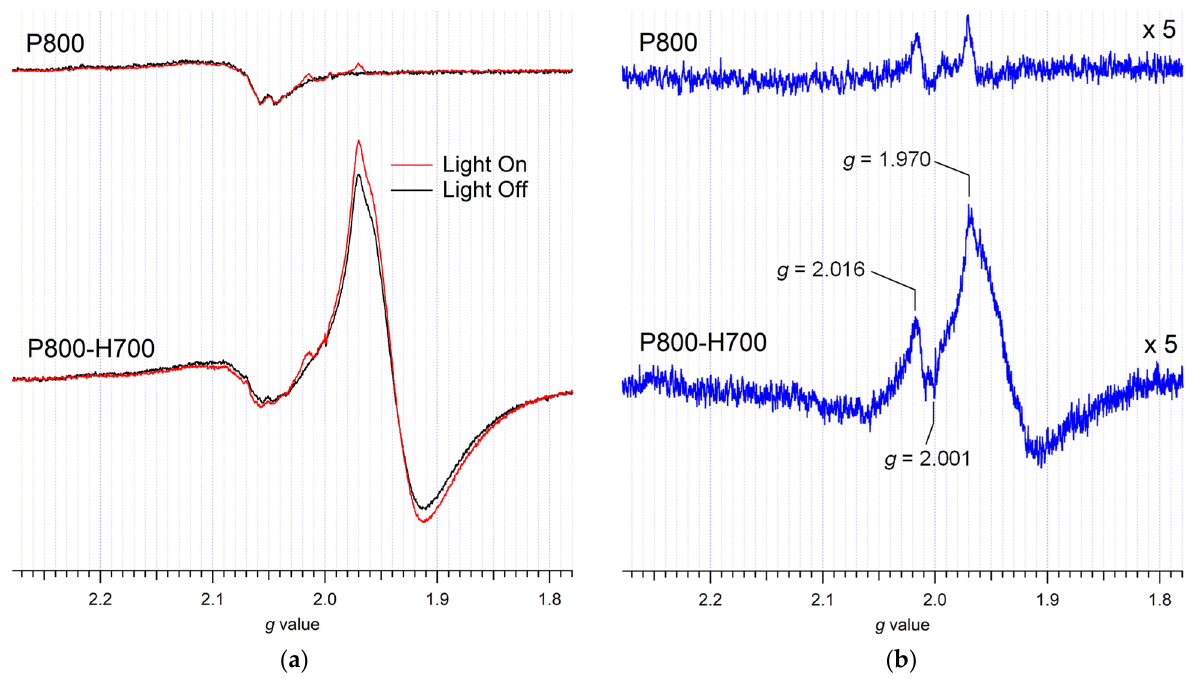
Figure 6. ( a ) ESR spectra of P800 and P800-H700 with helium (18 Torr) at − 253 ◦ C. ( b ) Difference spectra between before and after UV irradiation at 365